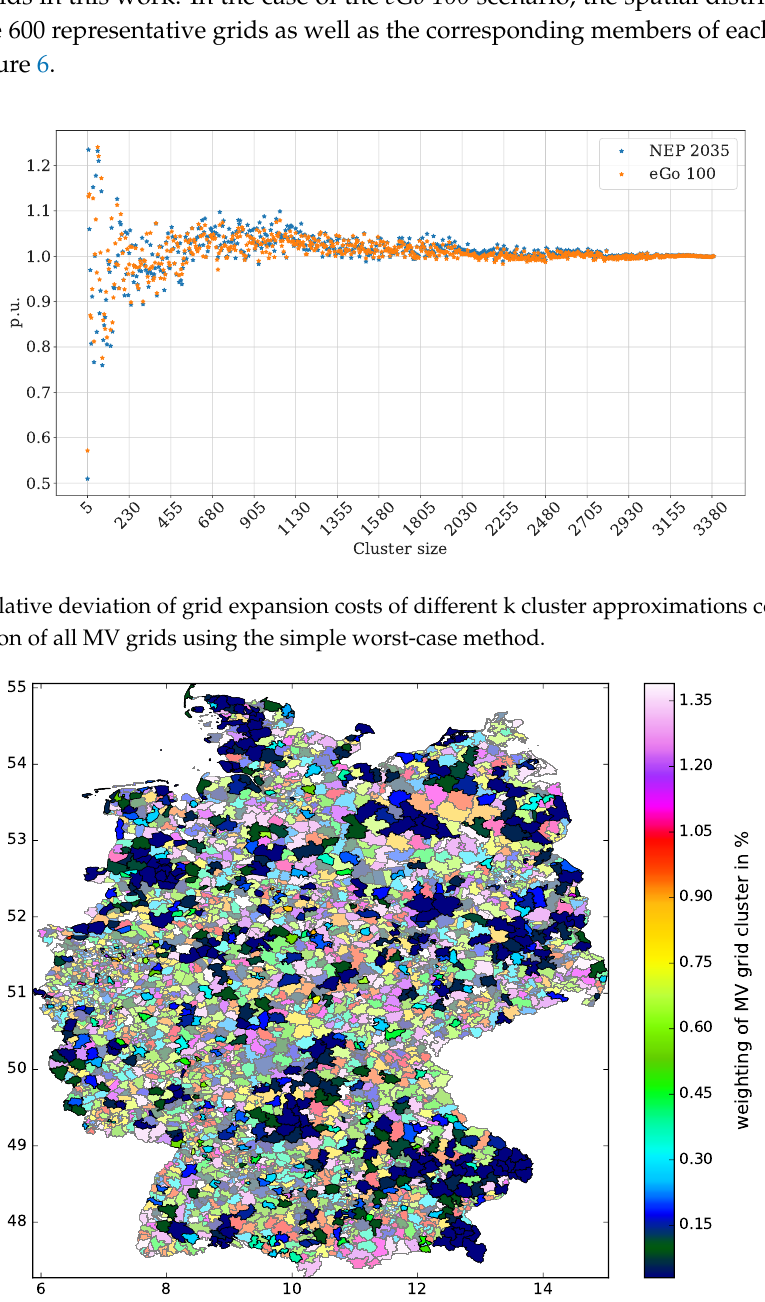
Figure 6. MV grid clusters with 600 representative MV grids (black-rimmed) and their weighting for the eGo 100 scenario. The MV grid districts are displayed without any grid